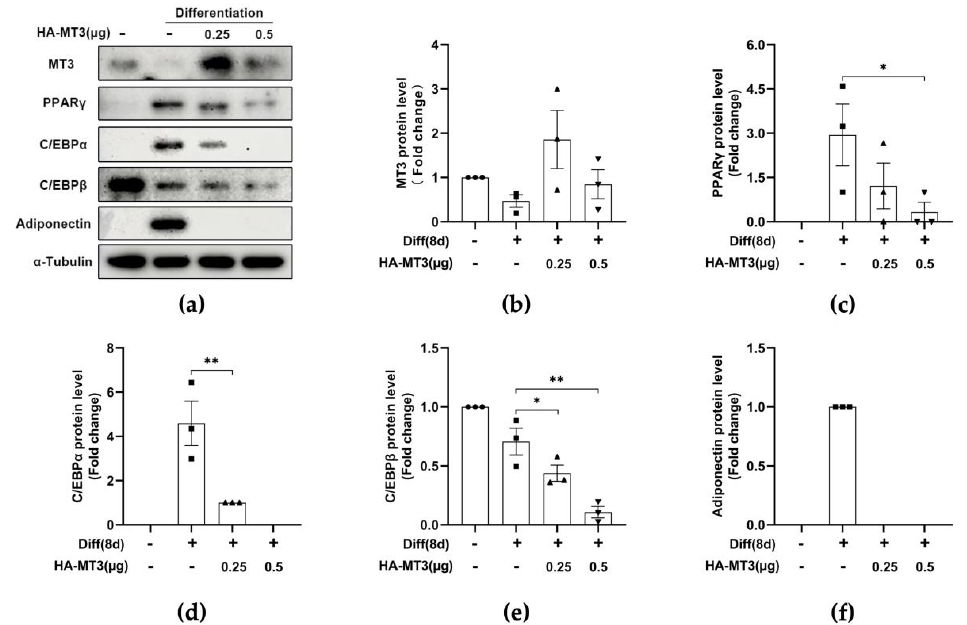
Figure 4. Mt3 overexpression reduces the protein levels of adipogenic transcription factors in 3T3-L1 adipocytes. 3T3 − L1 cells were transfected with HA − MT3 plasmid (0.25, 0.5 μ g) prior to contact inhibition and induced adipocyte differentiation using differentiation cocktail. ( a ) The protein levels of MT3, PPAR γ , C/EBP α , C/EBP β , adiponectin, and α -Tubulin in the different groups were measured by immunoblotting. α − Tubulin was used as a loading control. ( b – f ) The intensities of bands (MT3, C/EBP α , C/EBP β , PPAR γ , and adiponectin) were quantified and normalized with the corresponding